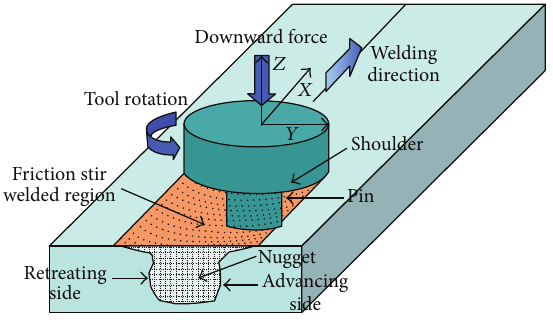
Figure 1: Schematic of friction stir welding process [1]. benefits include lower energy consumption compared to the conventional welding, surface cleaning, degreasing solvents, and negating harmful welding fumes and gasses and waste material